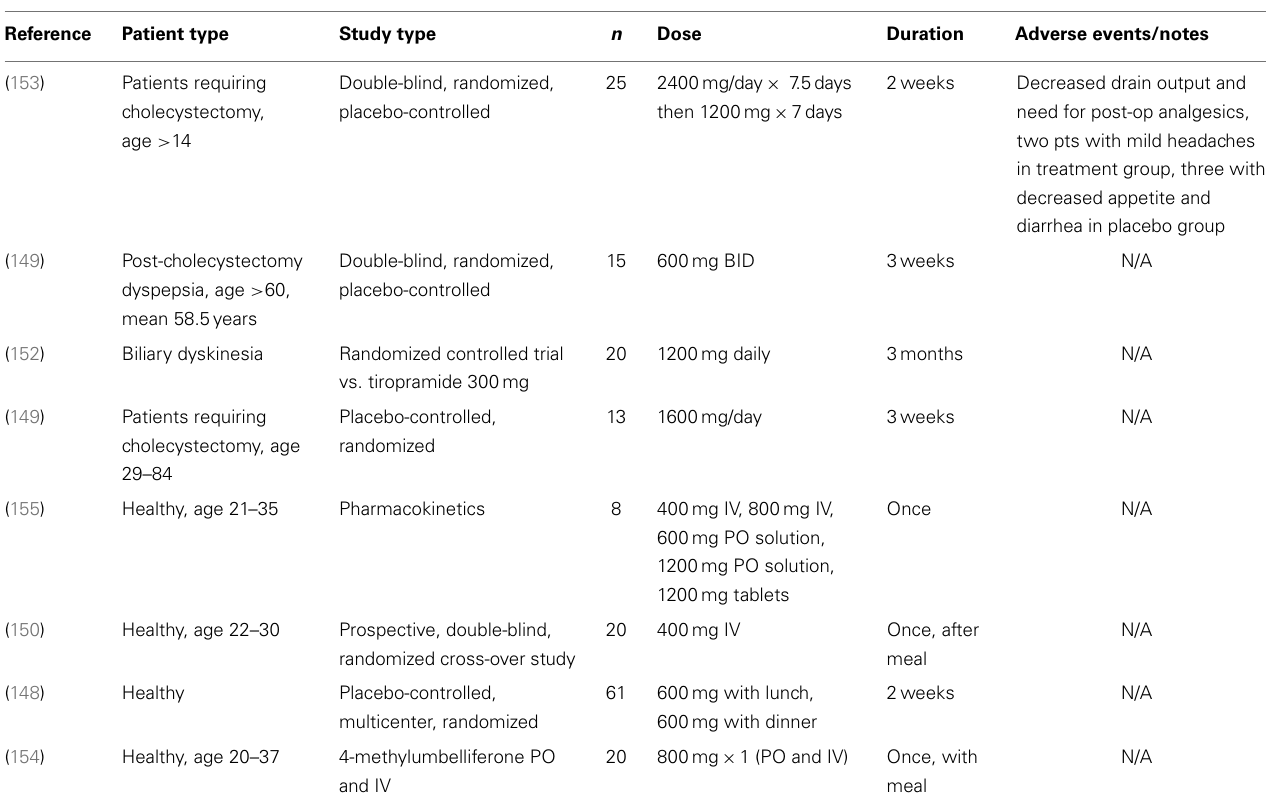
Table 2 | Clinical trials using hymecromone (4-MU) in humans